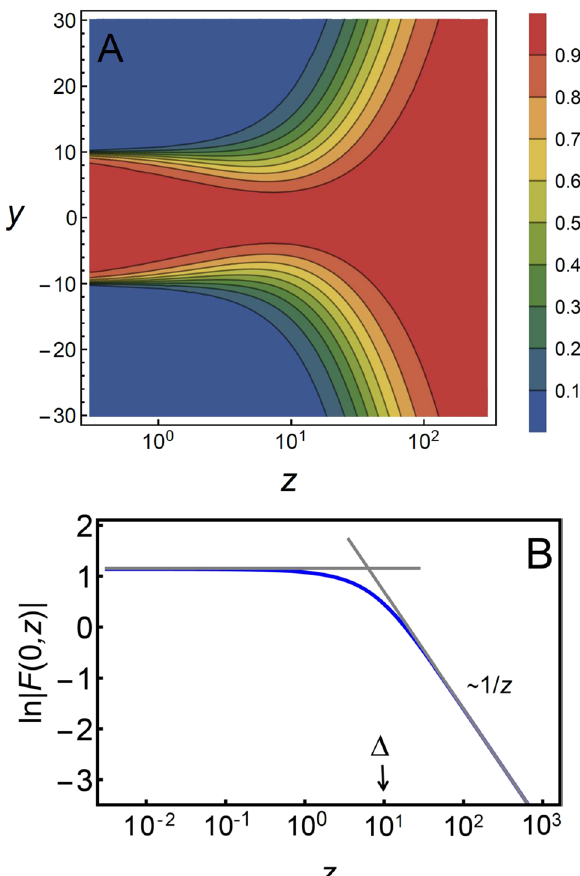
Figure3: Nearfield of thesingle-aperturemetasurface;seeEq.(14). (A) Contour plot of Re 2 [ F ( y , z )]/Re 2 [ F (0, z )] for Δ (cid:2) 10 and L = 1. (B) ln | F (0, z ) | versus z (bluecurve).Graycurvesareasymptotes.Forsmall (large) z , F is nearly constant ( F ∝ 1/ z